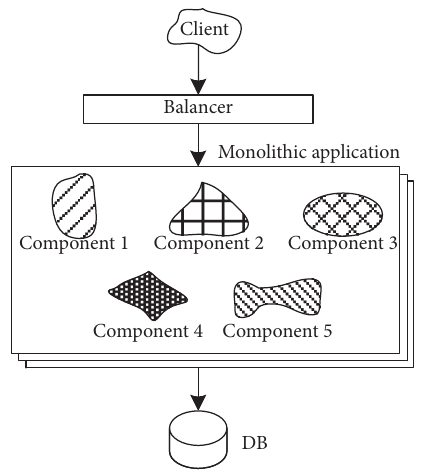
Figure 1: Framework of monolithic